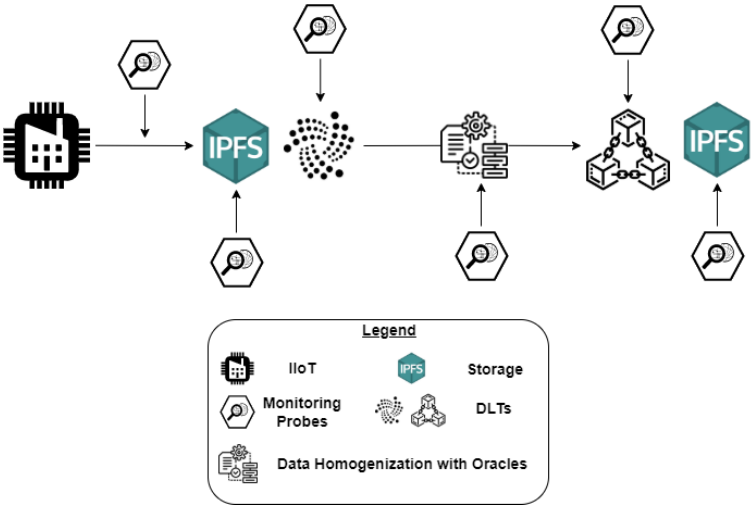
Figure 6. Monitoring probes placement across the presented